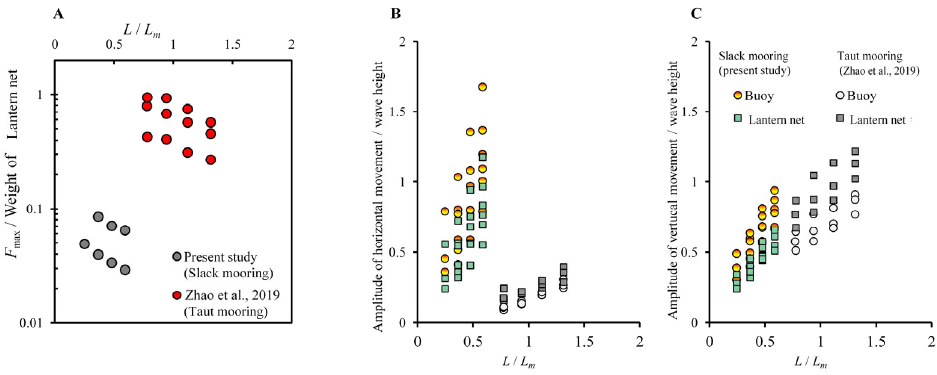
Figure 9. Relationships between ( A ) F max /weight of lantern nets, ( B ) amplitude of horizontal movement/wave height, ( C ) amplitude of vertical movement/wave height and L / L m ( L : wavelength, L m : length of the main line)